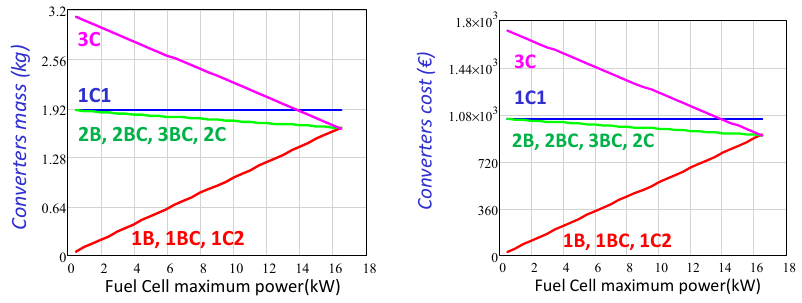
Figure 10. Power converters mass and cost.